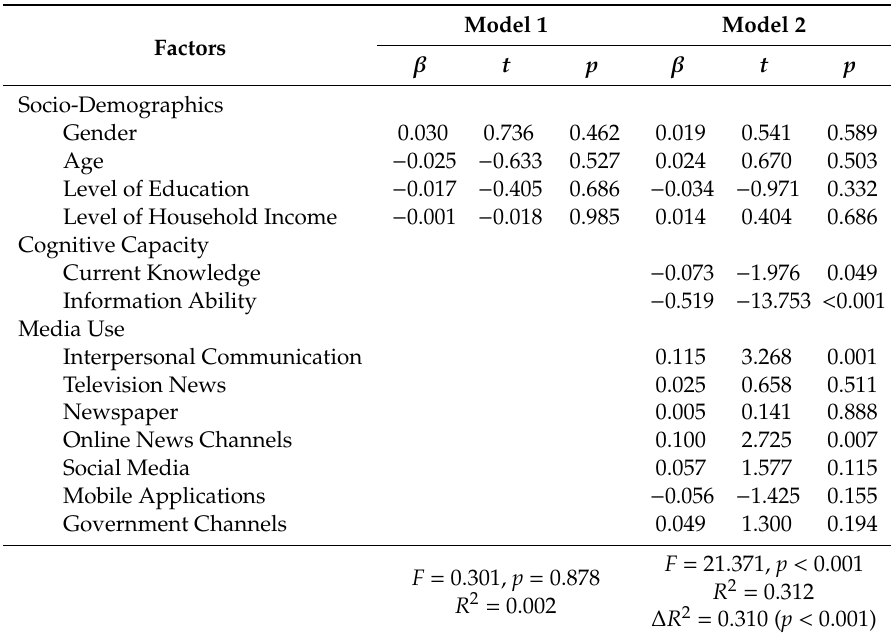
Table 1. Hierarchical regression